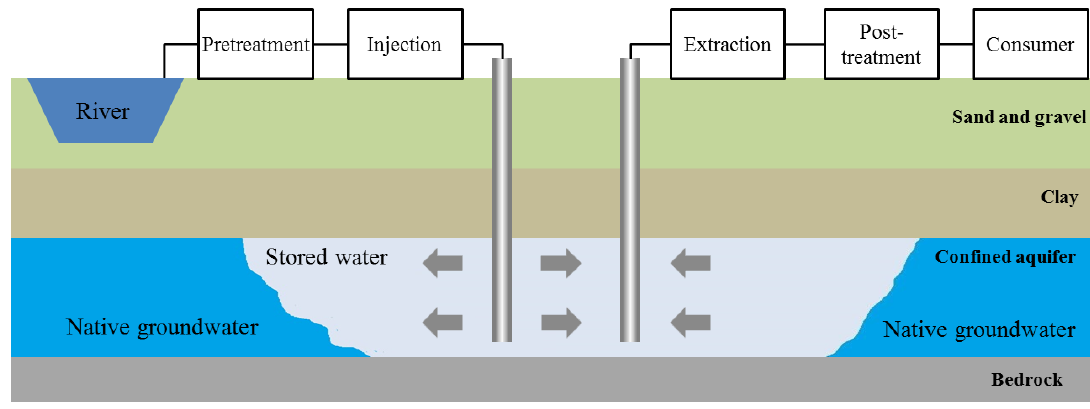
Figure 1. Schematic representation of drinking water production process using ASTR.